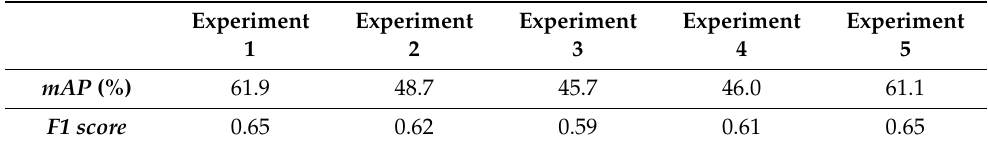
Table 12. Results of Faster R-CNN on CCTSDB2021 dataset.